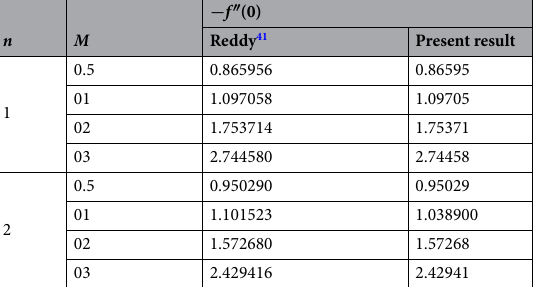
Table 2. Comparison of − f ″ (0) with 41 for numerous values of n and M when = . Pr 0 7, φ =